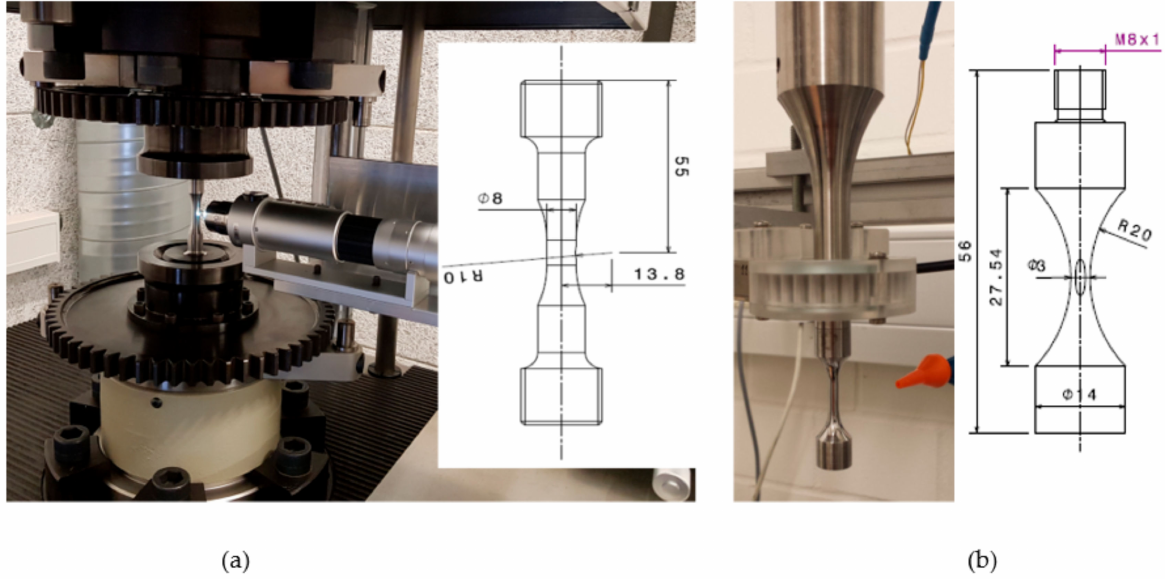
Figure 5. Specimen geometries (all dimensions in millimeters) for ( a ) the resonance fatigue testing system RUMUL Testronic (95 Hz), and ( b ) the ultrasonic fatigue testing equipment of the type BOKU Vienna (20